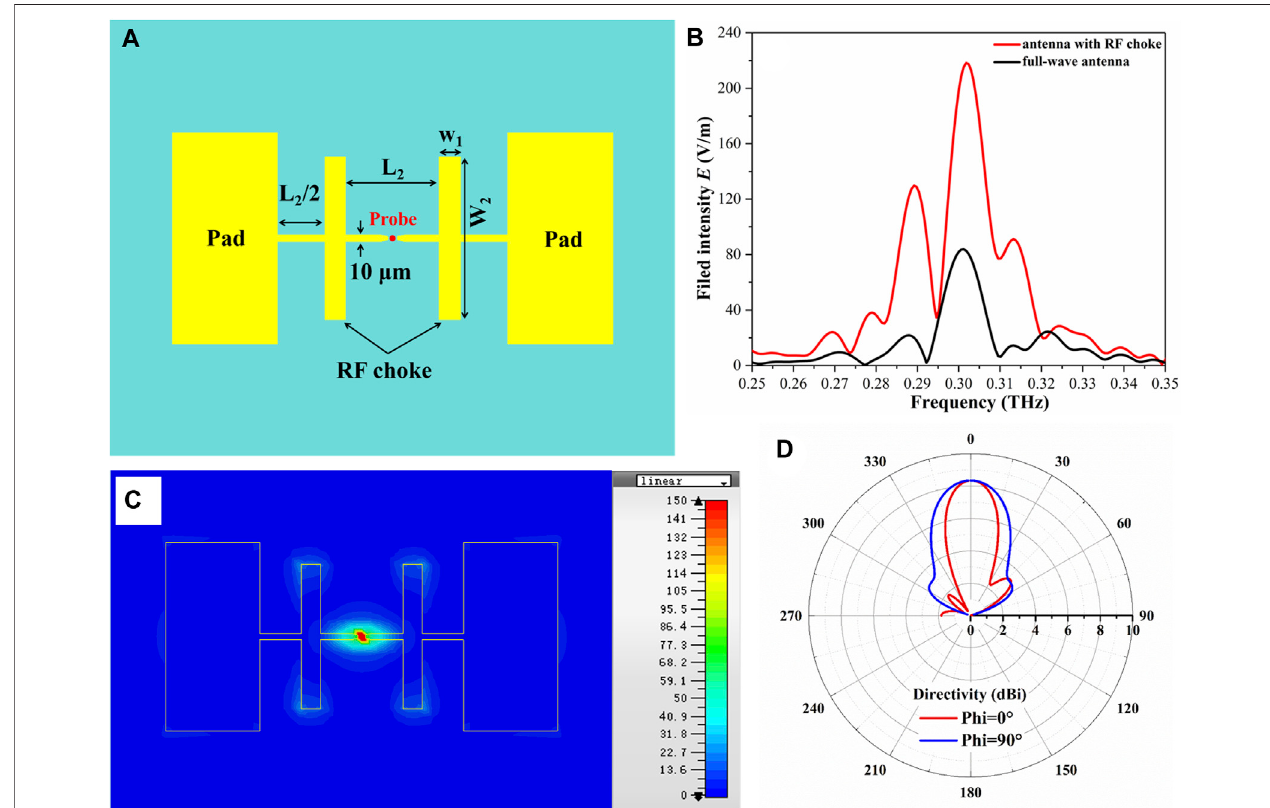
FIGURE 2 | (A) Schematic diagram of the dipole antenna with RF choke on the Si substrate. (B) The curve of the electric fi eld intensity varies with the frequency of the dipole antenna with or without RF choke. (C) The electric fi eld intensity distribution of the dipole antenna with RF choke near the surface of the Si substrate at 0.301 THz. (D) The radiation patterns of the planar dipole antenna with RF choke at 0.301 THz.